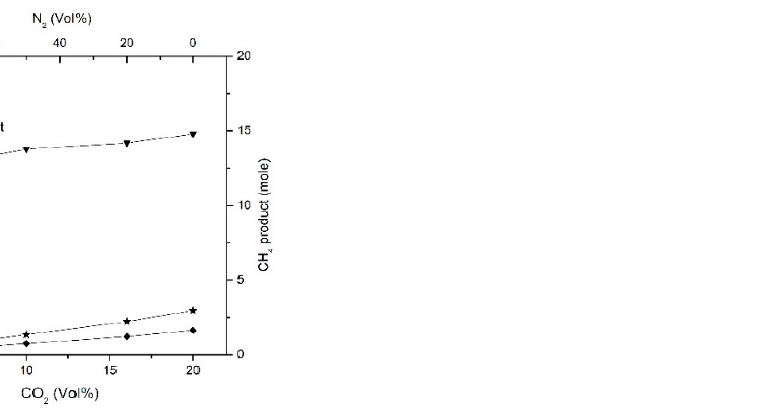
Figure 7. Effect of CO 2 concentrations on the H 2 conversion and CH 4 production.(GHSV = 30,000/h, H 2 /CO 2 = 4).